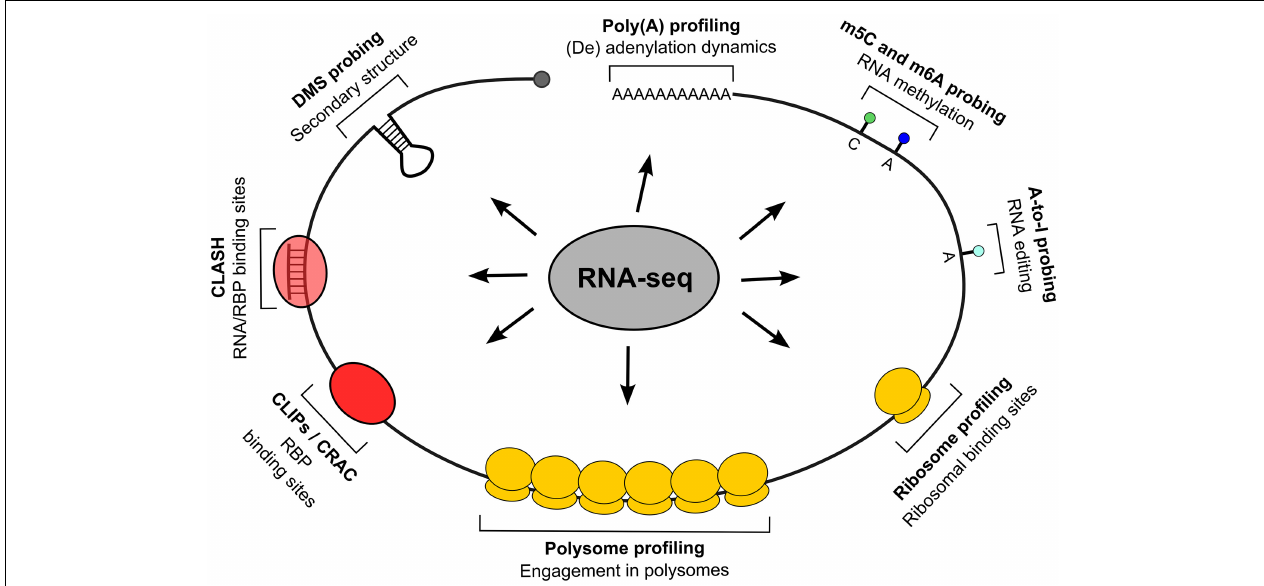
FIGURE 1 | Techniques for positional whole-transcriptome probing. The figure displays techniques allowing to study transcriptomes at various observational levels, with particular regard to positional information; all techniques, indicated by their representative feature on transcripts, are based on